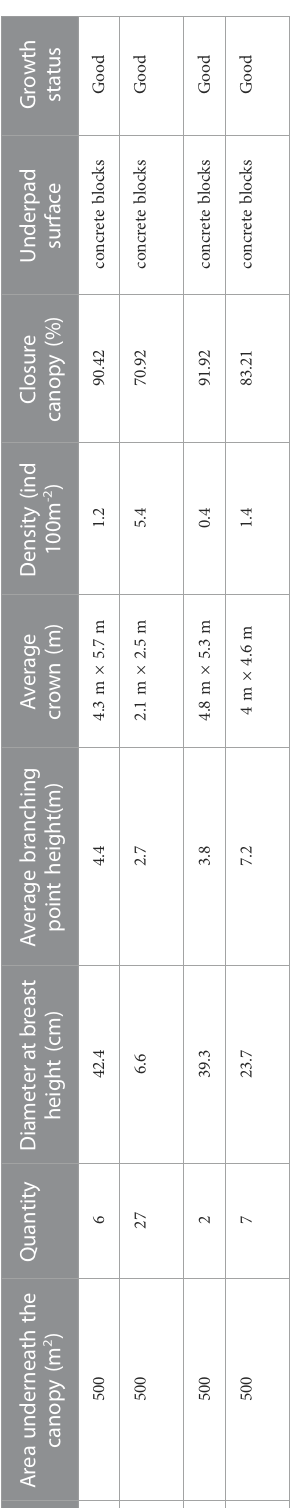
Taking the data from the weather stations as the control group, we analyzed the differences in temperature of the areas underneath the canopies of the four tree species using a one-way analysis of variance. During the winter, the results of the analysis of variance for the four tree species during three periods were as follows: F = 0.058, p = 0.981